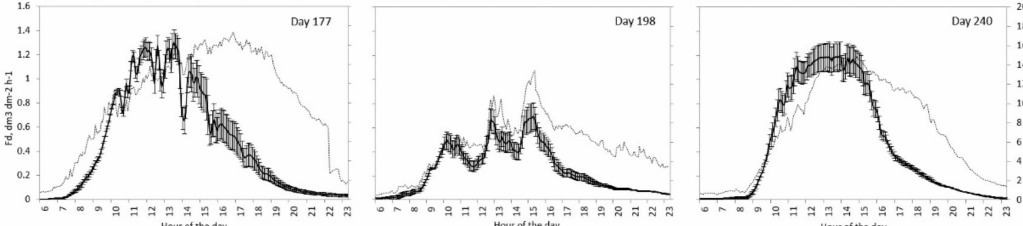
Figure 2. Average sap flow densities from two probes per tree in day 177, 198, and 240 of summer 2018. Bars represent the standard error. VPD (hPa) appears in the